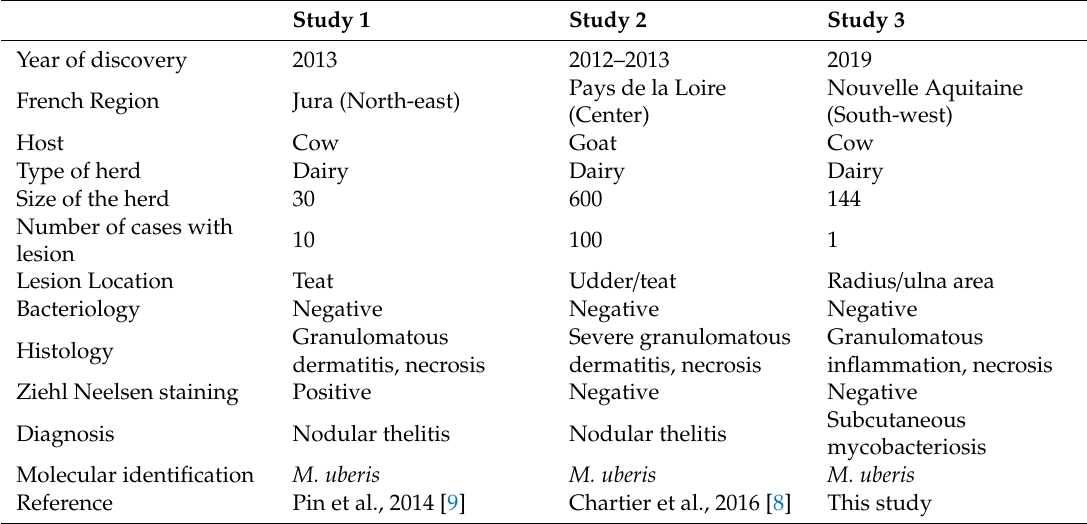
Table 2. Comparison of the M. uberis cases identified in